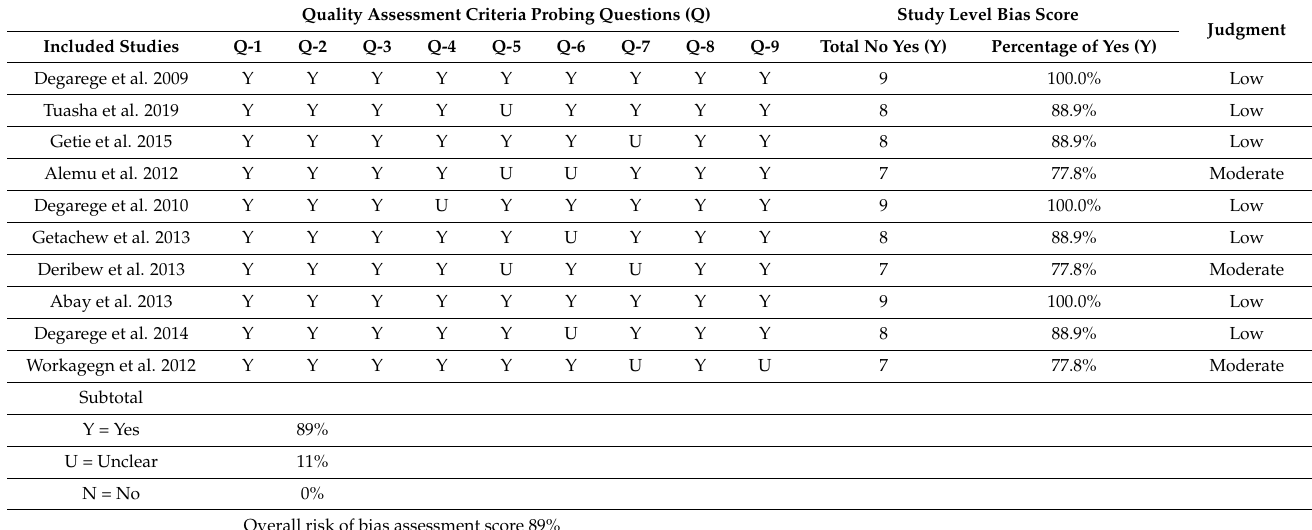
Table 1. The quality assessment of the studies included for the pooled estimate of comorbidity of geo-helminthes and malaria among the outpatients in Ethiopia.